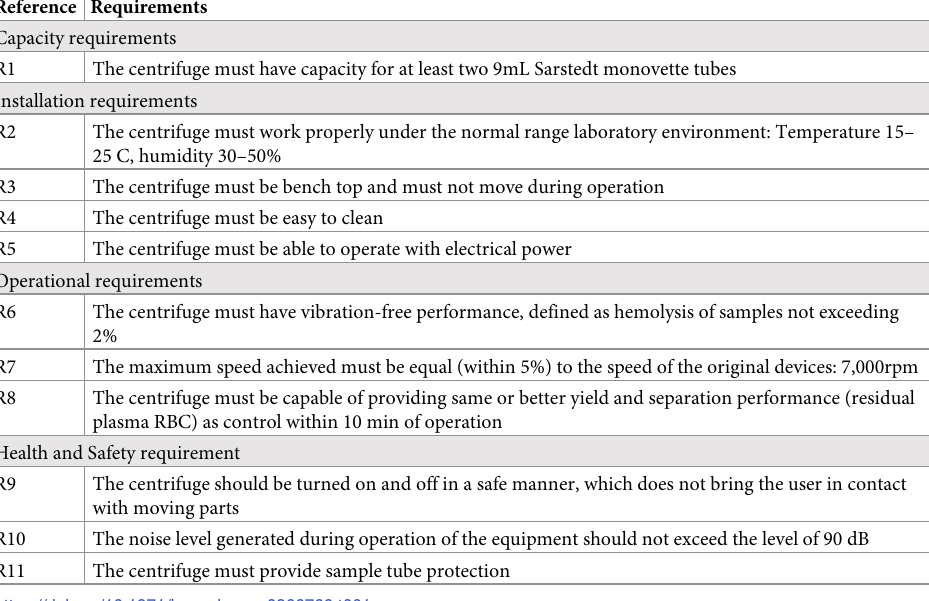
Table 1. Design requirements.